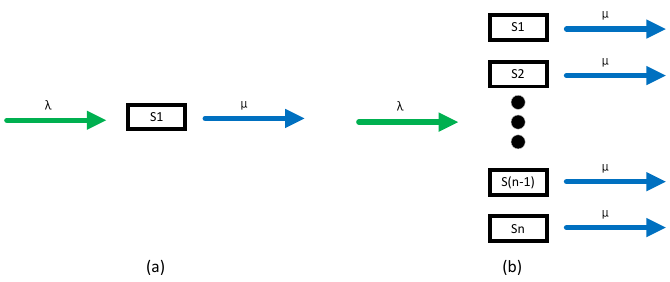
Figure 2. Coexisting WBANs system illustration.